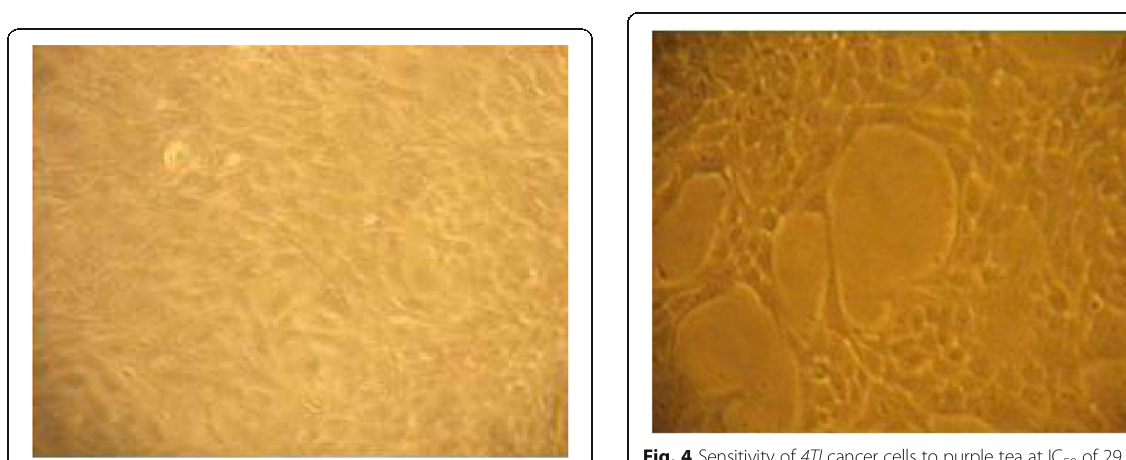
Fig. 2 A monolayer of 4TI control cells after 48 h in DMEM media